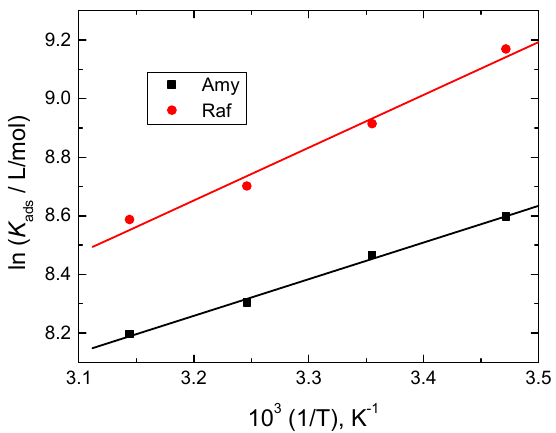
Figure 10. Van’t Hoff plots for Amy and Raf adsorbed on Al surface in 0.1 M NaOH medium. Table 5. Values of K ads and thermodynamic parameters for Al corrosion inhibition in 0.1 M NaOH medium by Amy and Raf at various temperatures.